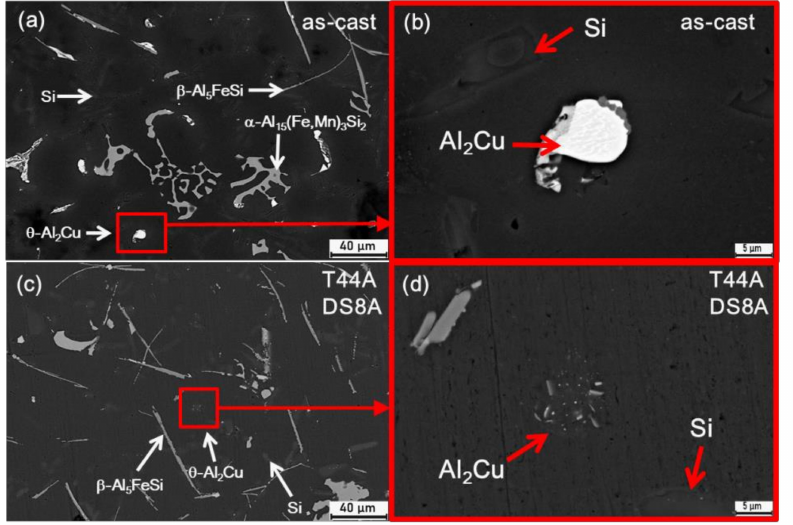
Figure 2. Microstructural observation of the Al6Si2Cu alloy: ( a ) BSE(backscatter electron) micrograph showing various as-cast phases; ( b ) BSE micrograph showing the Al 2 Cu and Si phases of as-cast; ( c ) BSE micrograph showing various T44A-DS8A phases; and ( d ) BSE micrograph showing the Al 2 Cu and Si phases of T44A-DS8A.